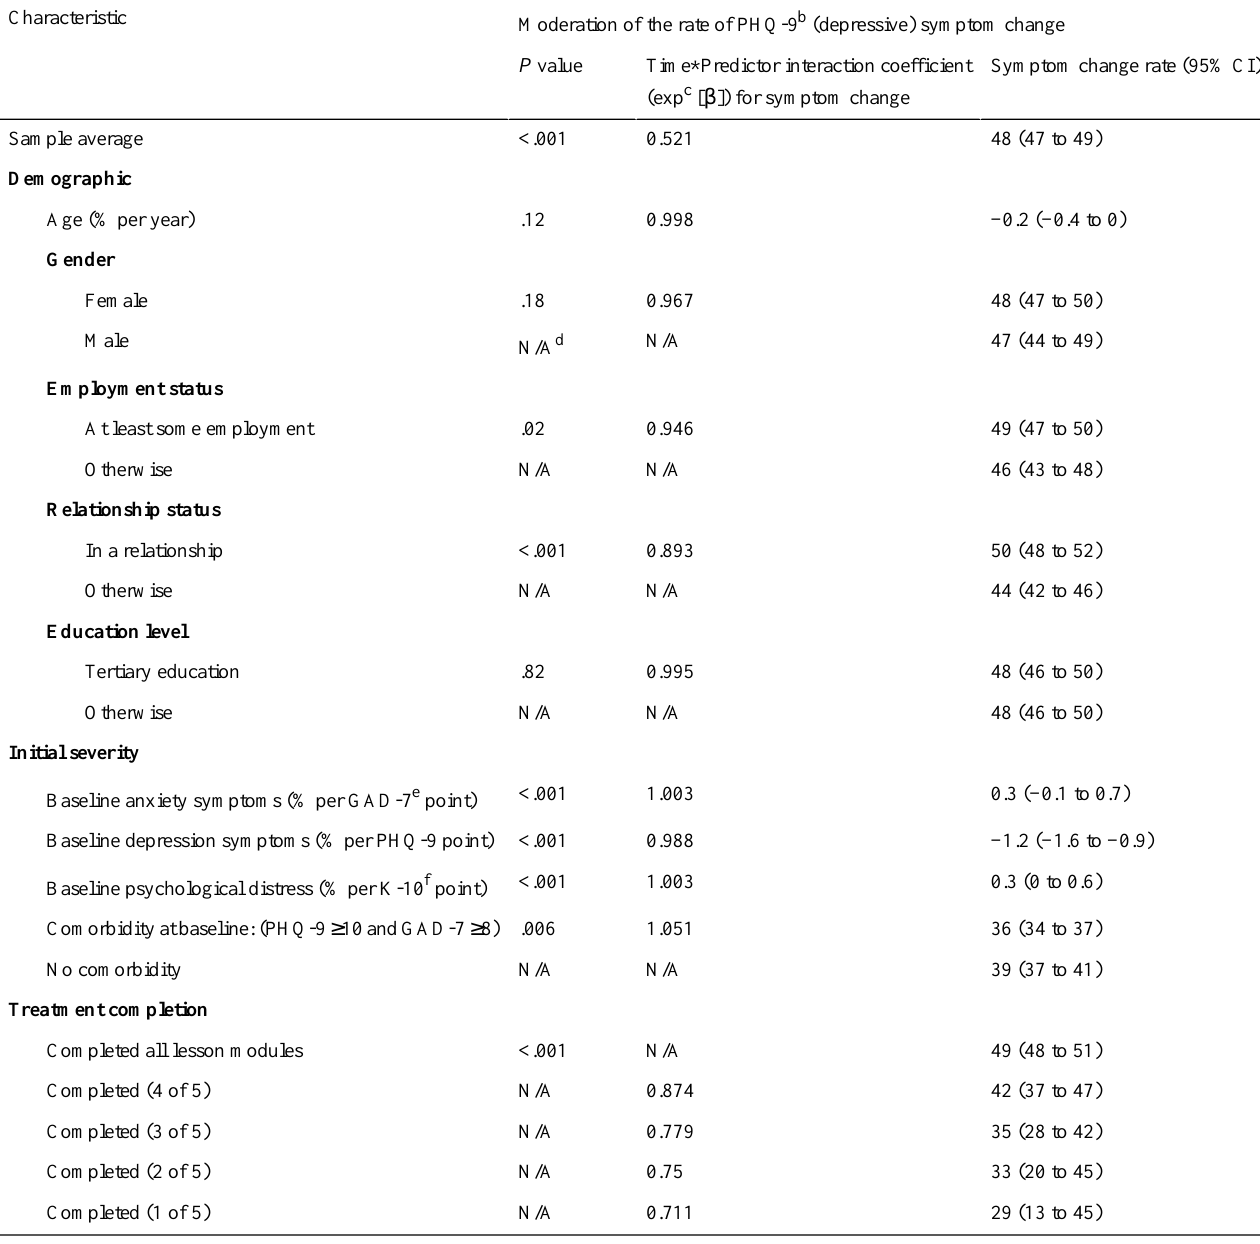
Table 6. Longitudinal estimates of average depressive (Patient Health Questionnaire-9) symptom moderation.